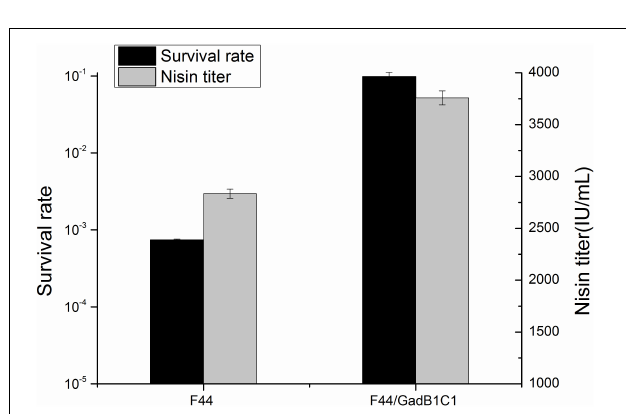
FIGURE 2 | Maximum nisin titer of F44 and F44/GadB1C1 in flask fermentation and their survival rate after 3 h exposure to pH